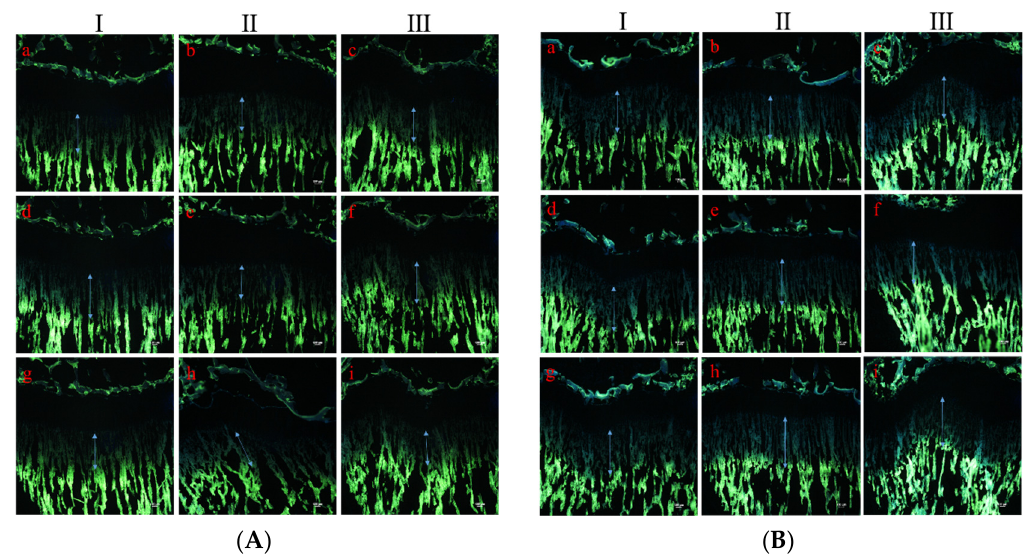
Figure 4. Typical fluorescent photography of the proximal growth plate of tibia. ( A ) Typical fluorescent images of the proximal growth plate of the tibia in the normal group. ( B ) Typical fluorescent images of the proximal growth plate of the tibia in the PEMF-treated group.